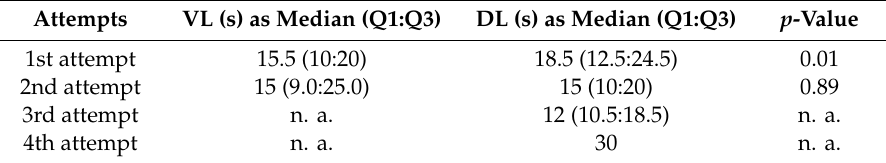
Table 4. Duration in relation to number of attempts for VL and DL in seconds (s).